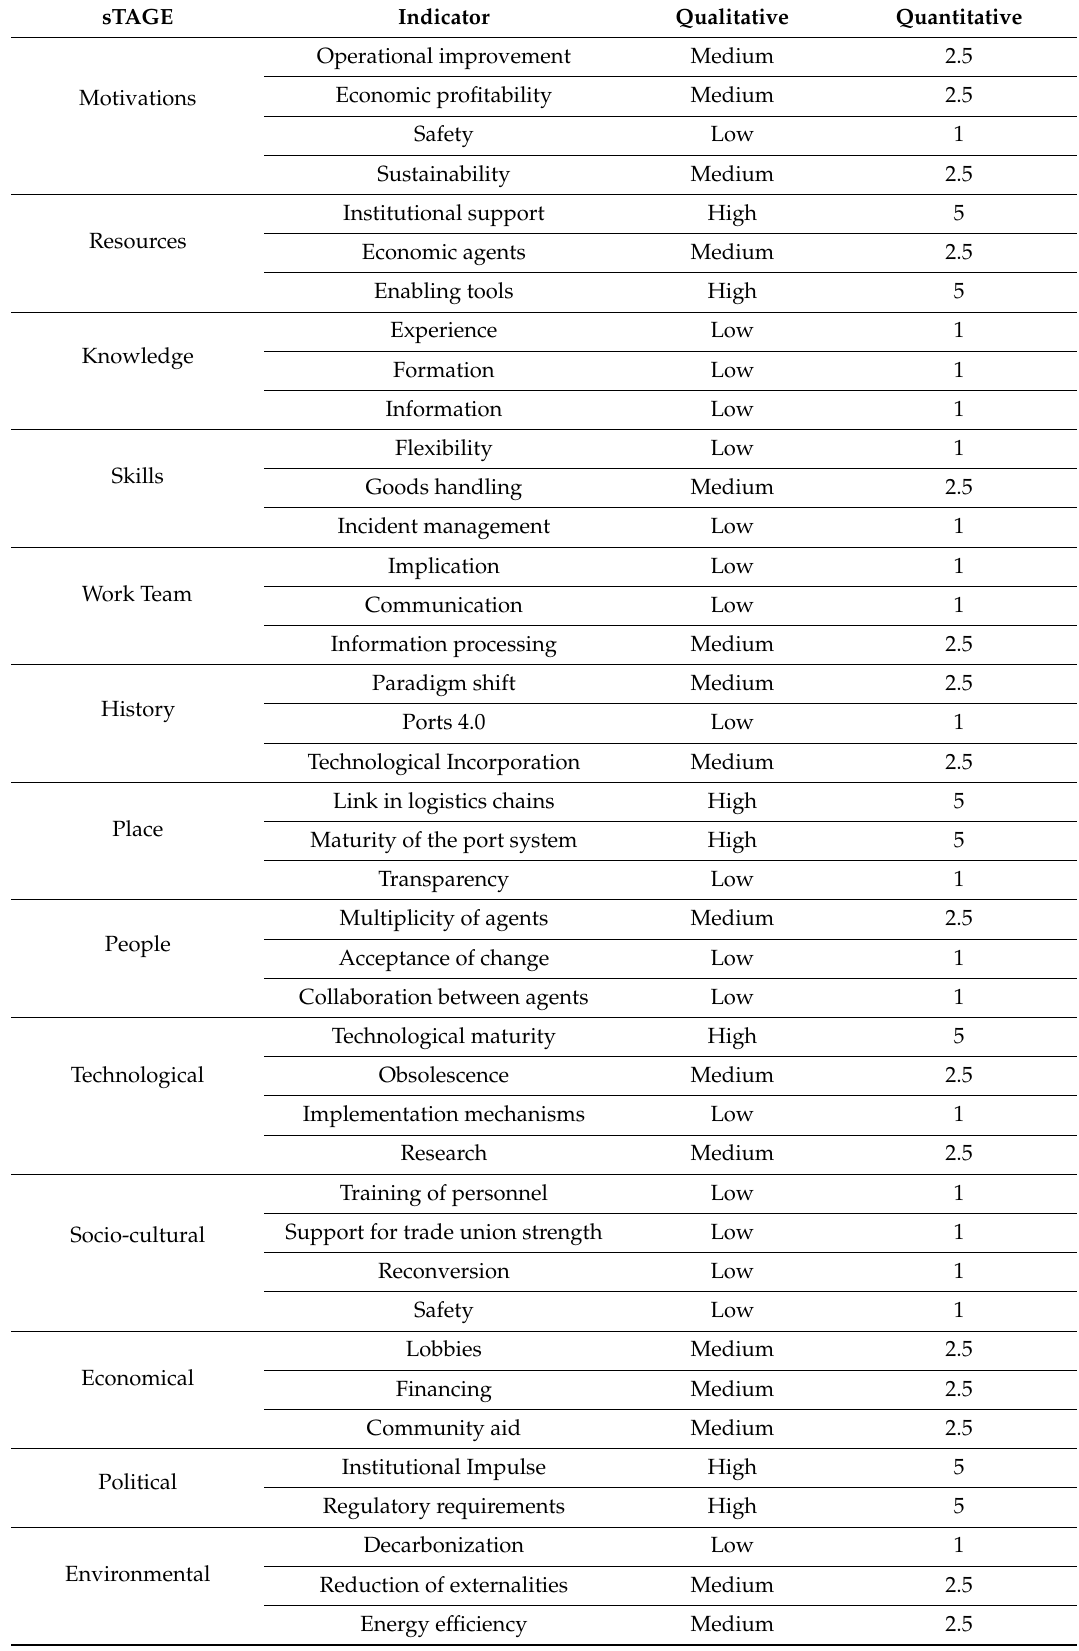
Table 3. Score of the